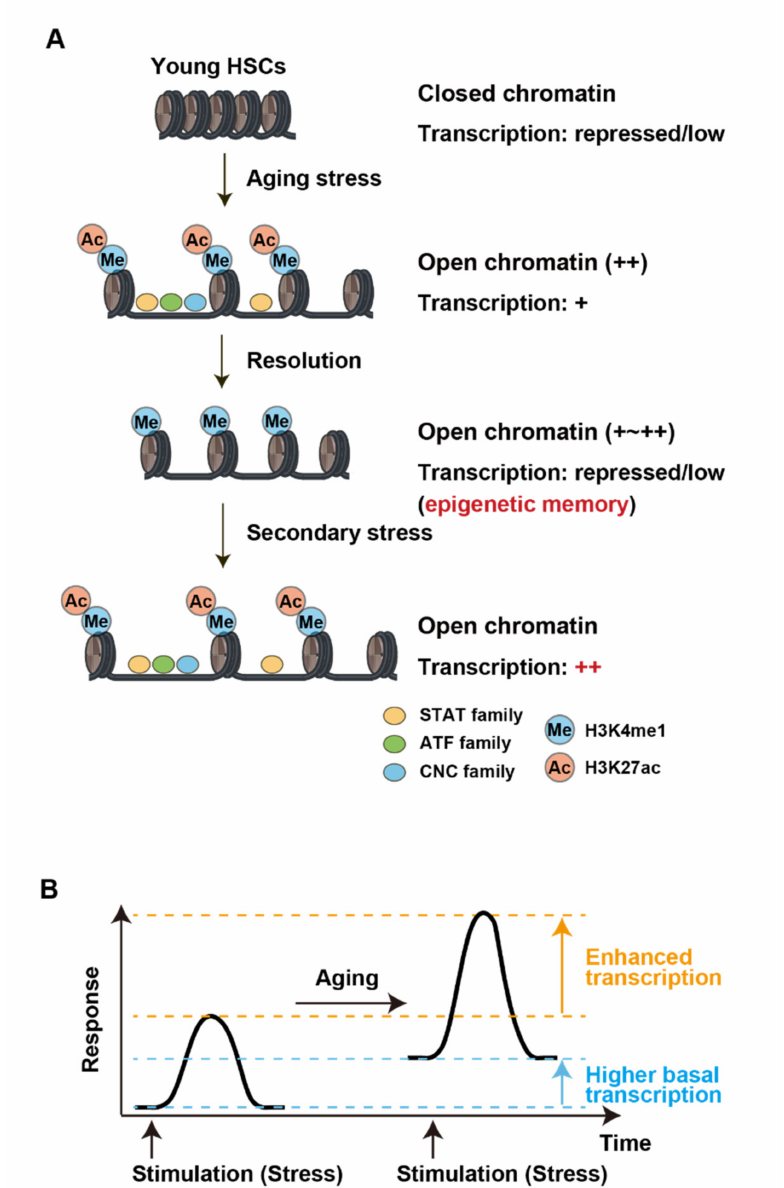
Figure 5. Epigenetic memory established by aging. ( A ) Aging stress-induced epigenetic memory inscribed in chromatin accessibility and histone modifications (H3K4me1 and H3K27ac). The tran- scription factors, the binding sites of which were enriched in DARs, are depicted. ( B ) Differences in transcriptional responses of open DAR-linked genes between young and aged HSCs